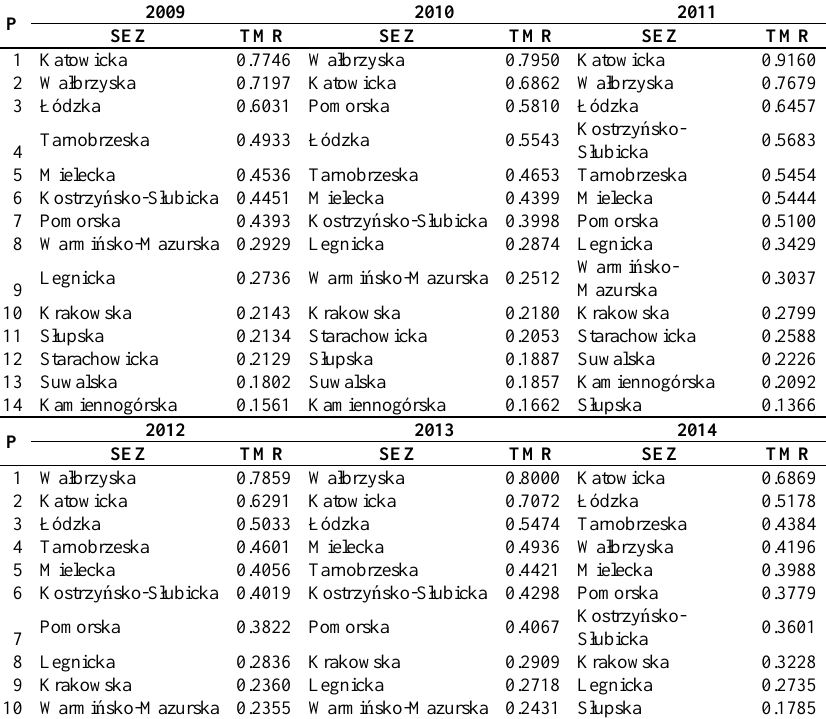
Table 2. Special economic zones arranged according to Hellwig’s measure in